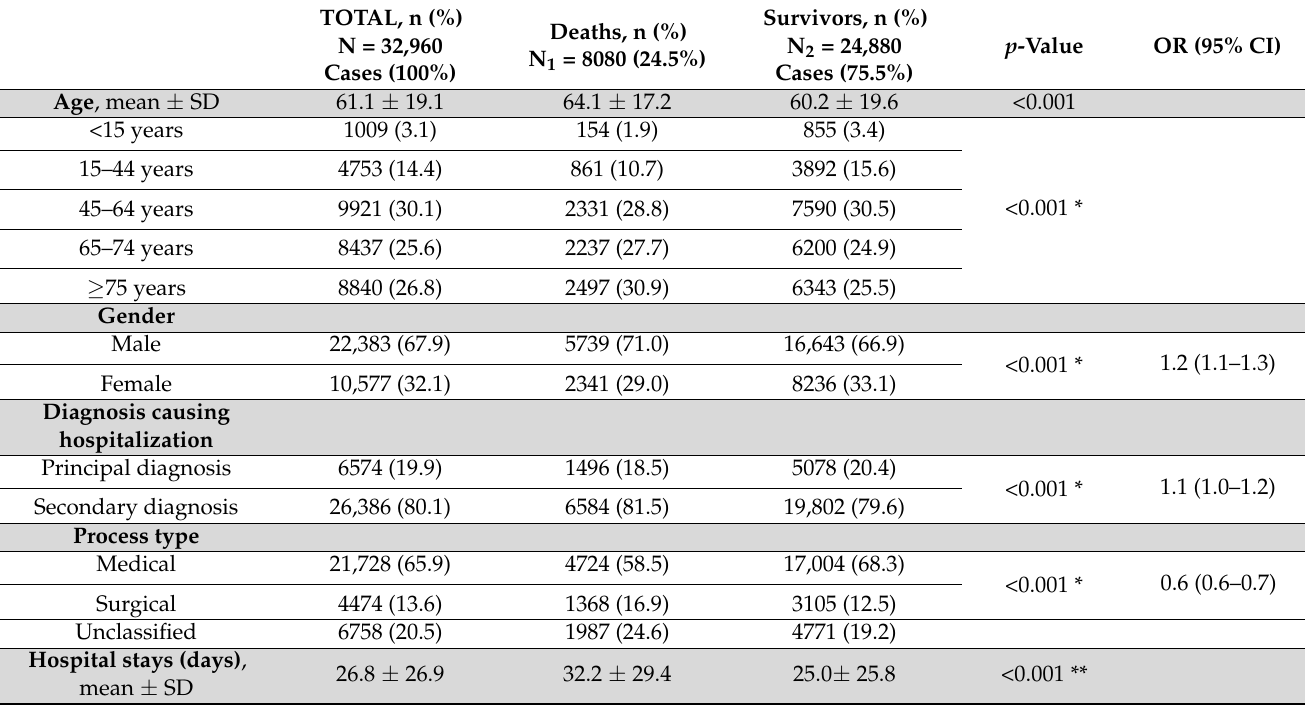
Table 1. Main comparative data of Aspergillus inpatients in Spain during 1997–2017: Deaths vs. Sur- vivors.